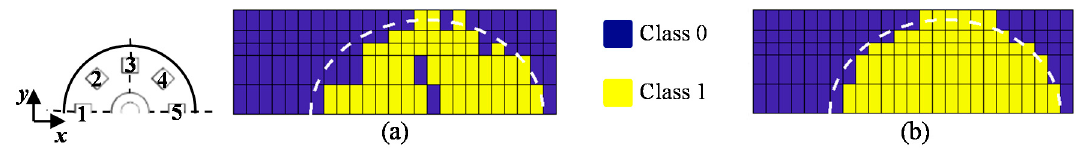
Figure 11. Visualization of the neighborhood based class probability update algorithm for the DCNN DND case.